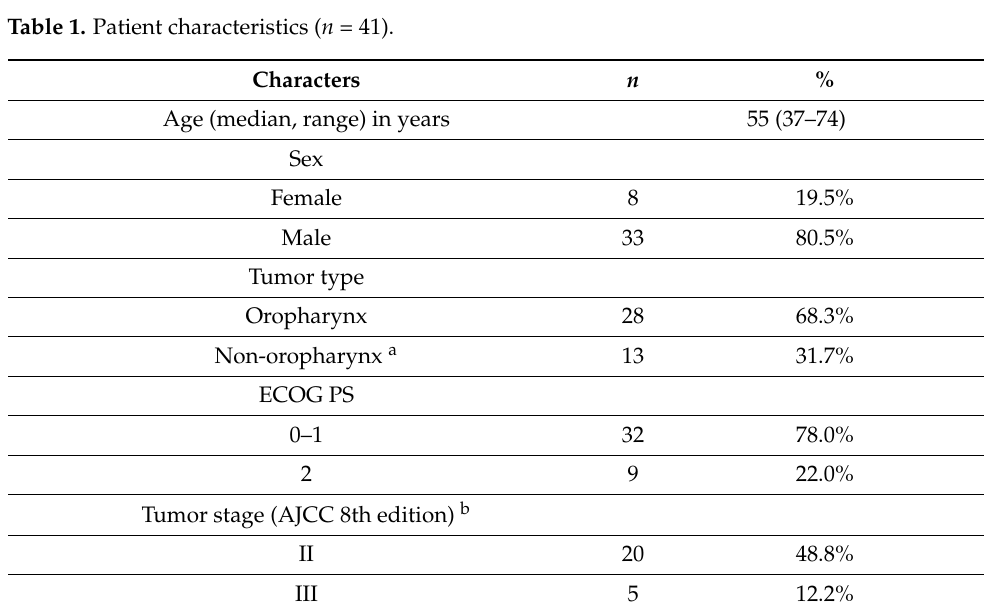
Figure 1. CONSORT algorithm.